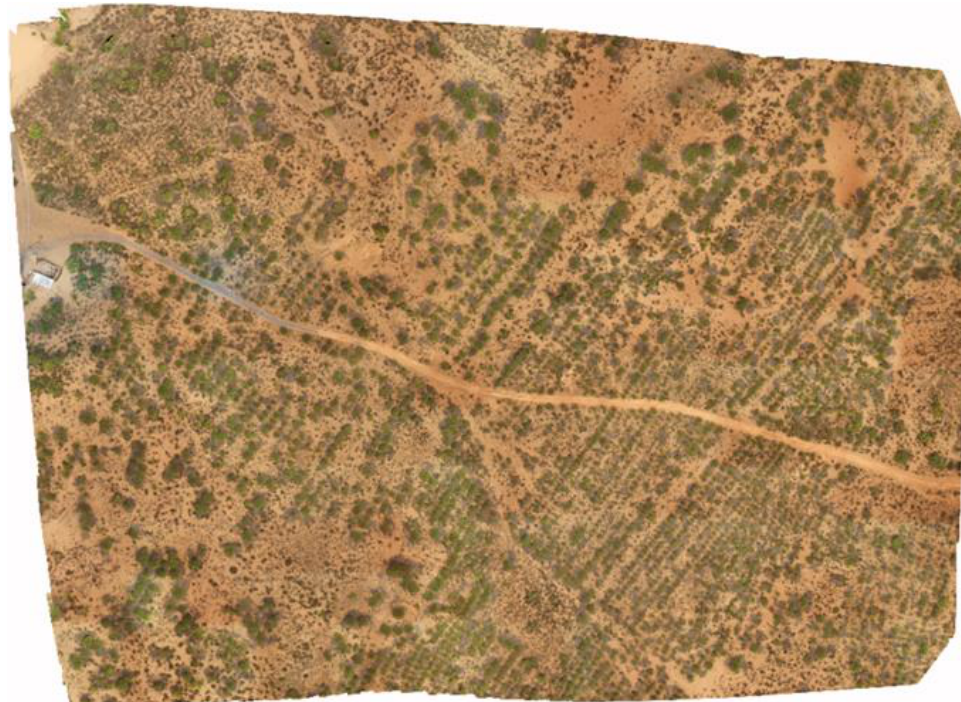
Figure 1. The UAV image synthesized through RGB bands.